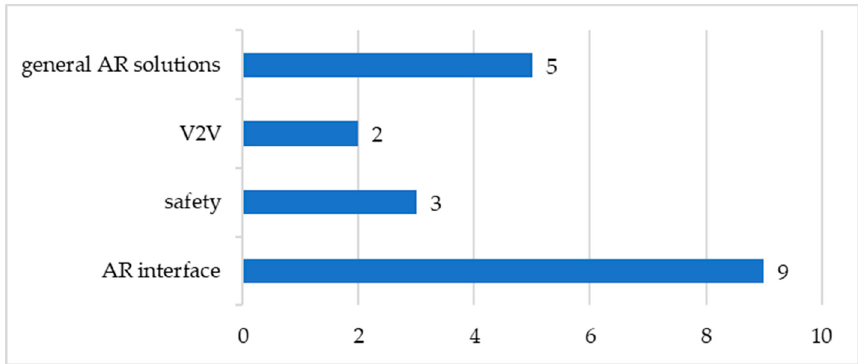
Figure 10. Distribution of papers related to ‘in-car’ AR systems according to their purpose.